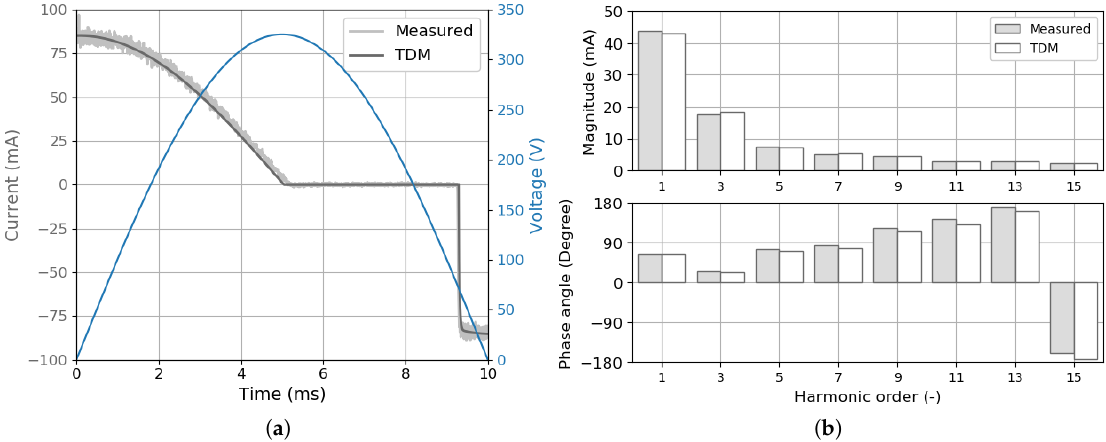
Figure A4. Comparison of measured data and the Type B LED lamp time-domain model (TDM) output at rated ideal sinusoidal condition: ( a ) Time domain. ( b ) Spectral